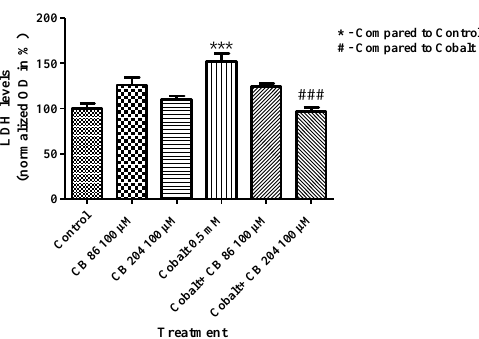
Figure 6. Prevention of CoCl 2 -induced cellular cytotoxicity by TSPO ligands. LDH cytotoxicity assay was performed to measure cytotoxicity levels following exposure to CoCl 2 with or without TSPO ligands pretreatment. Results are expressed as mean ± SEM ( n = 5 replicates in each group). ### and *** p < 0.001.